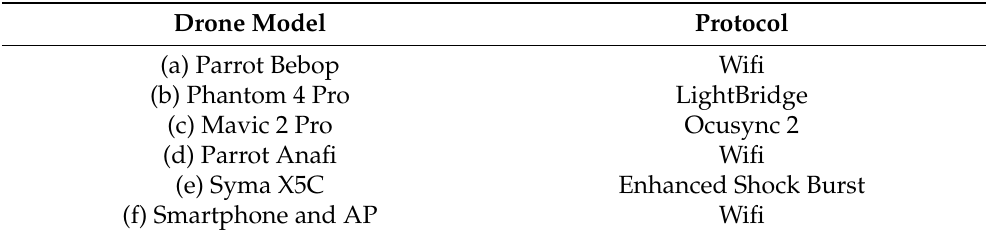
Table 1. Drone models.